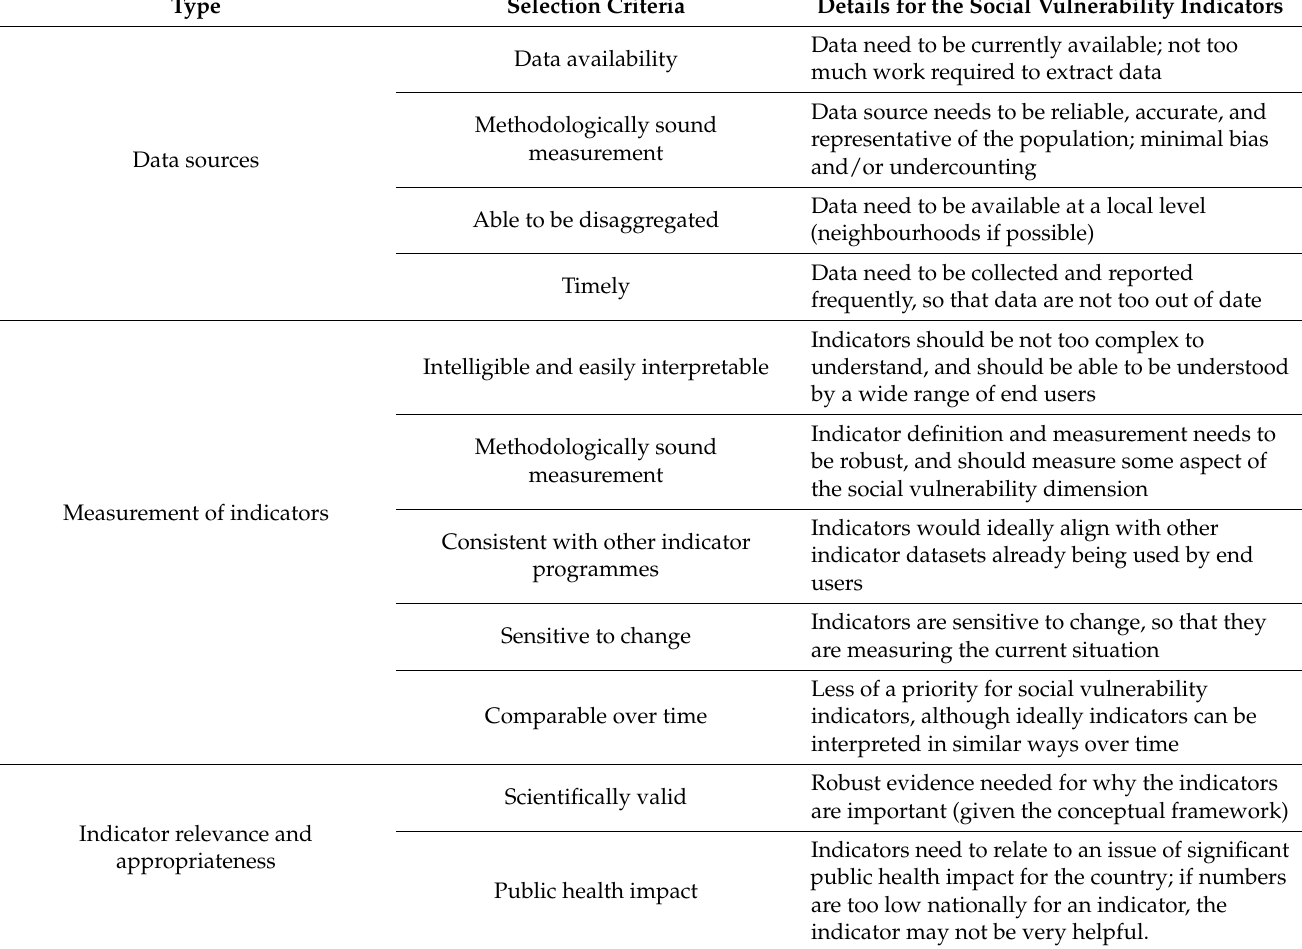
Table 1. Selection criteria for selecting social vulnerability